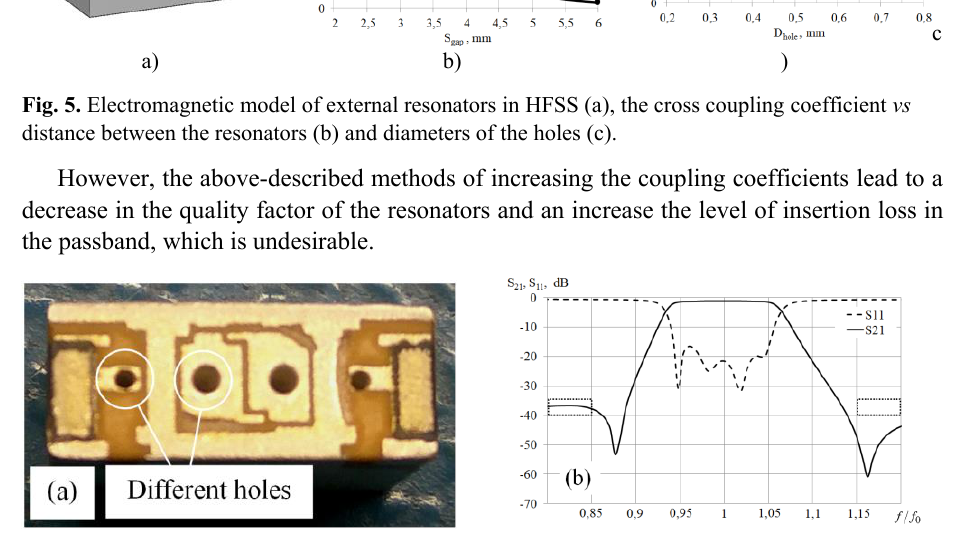
Fig. 6. QEF on MCB prototype with the classical topology (a) and its measured S -parameters (b)